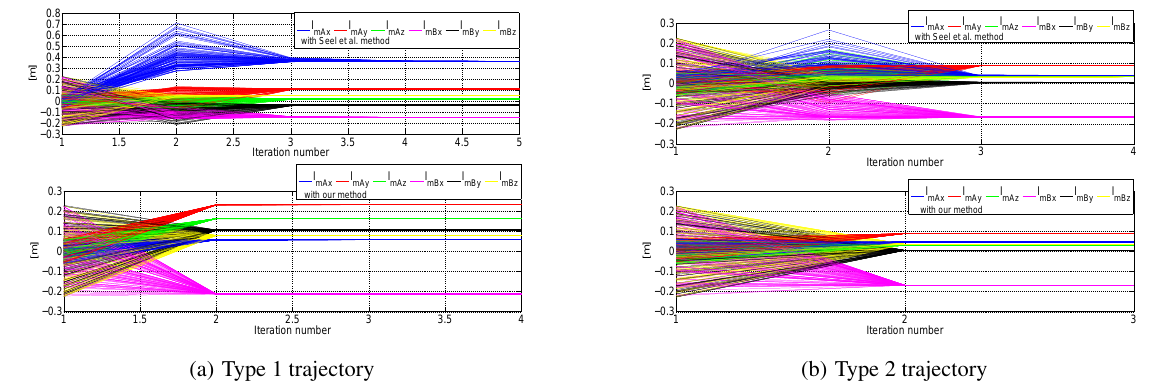
Figure 6: Convergence test with 100 random initial values for the IMU position. In this test the true value of l mA is [0 . 05 , 0 . 09 , 0 . 03] and the true value of l mB is [ − 0 . 17 , 0 . 004 , 0 . 03] .